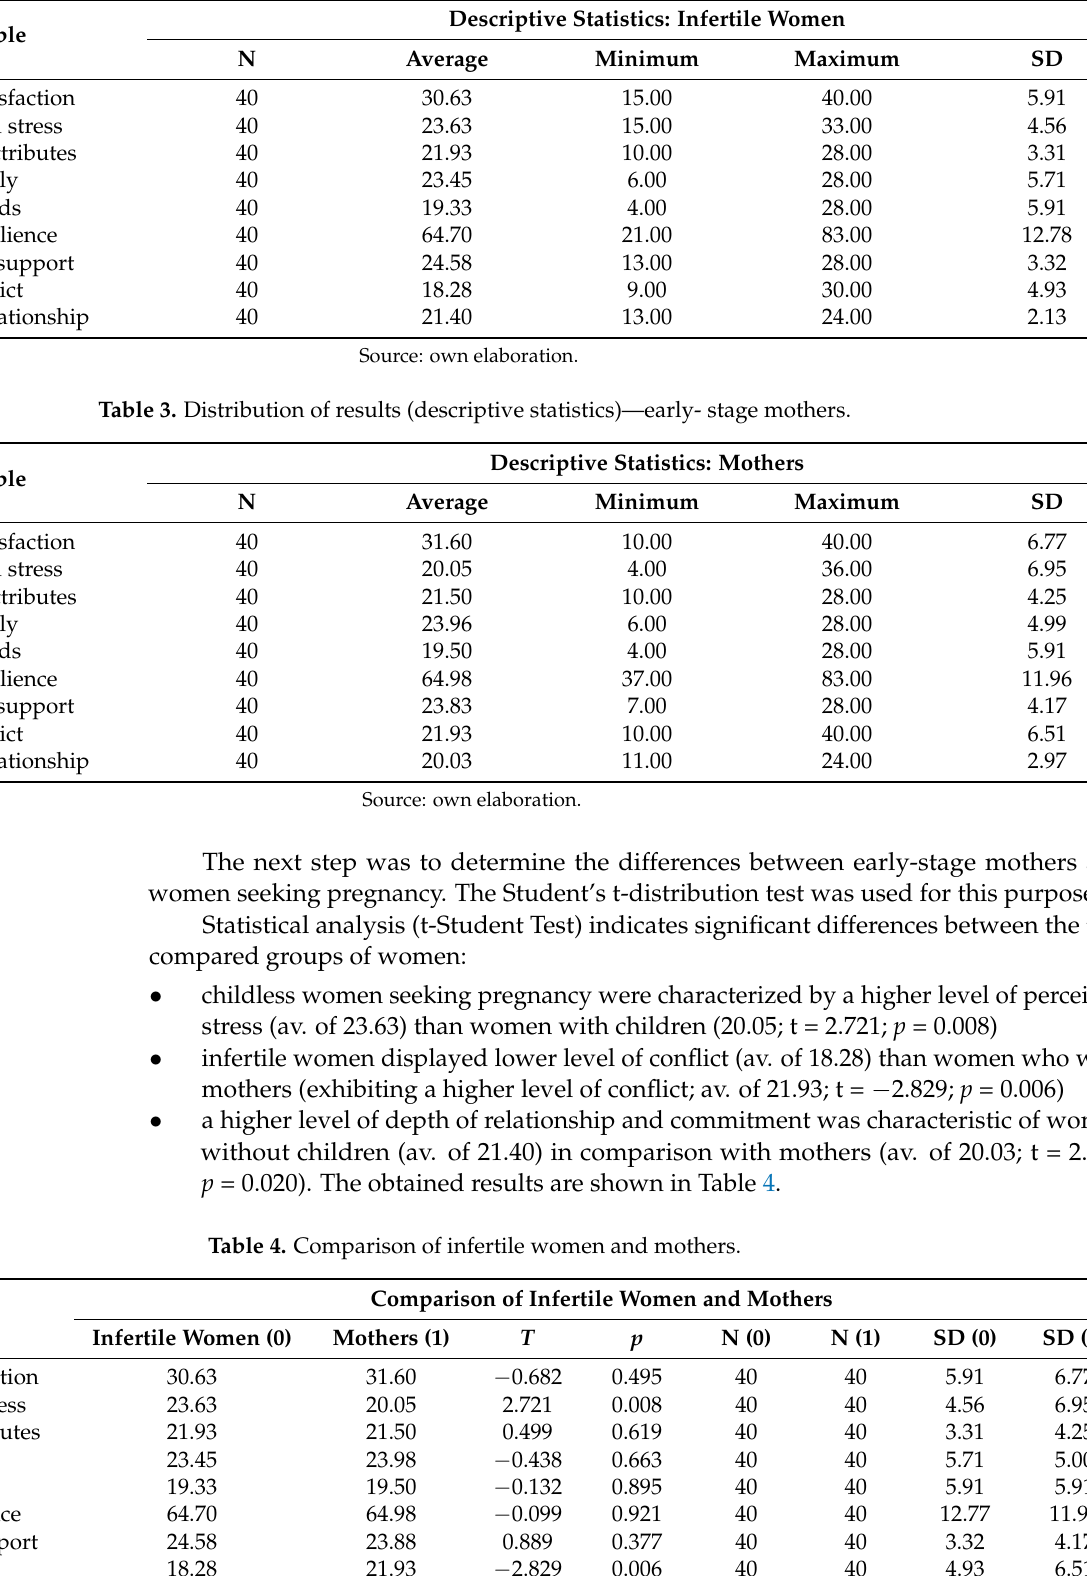
Table 2. Distribution of results (descriptive statistics)—women seeking pregnancy.